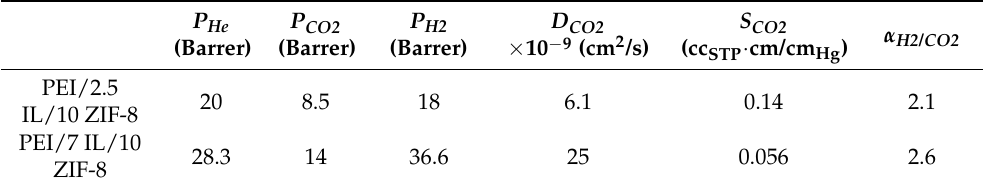
Figure 12. EDX spectra characterizing the different domains observed in SEM image of PEI/7 IL/10 ZIF-8. Table 4. Gas permeability, diffusivity and selectivity of the prepared membranes (the uncertainty was better than 5% for P and D and better than 10% for S and α